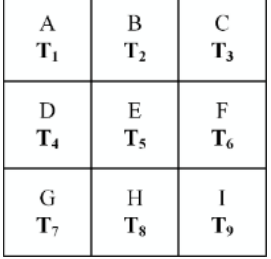
Figure 5. Tasks and files in a Moore neighborhood algorithm.